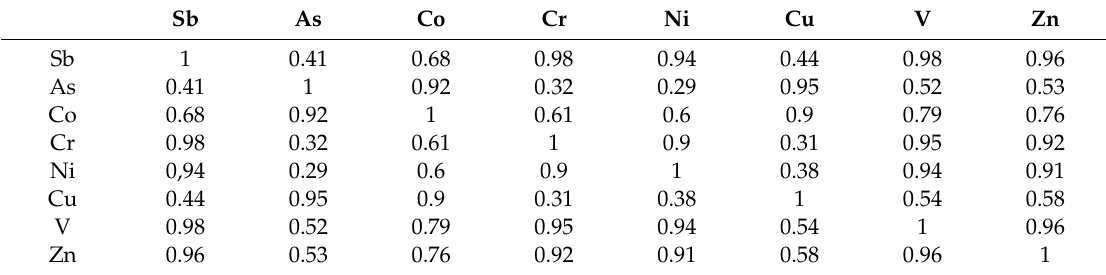
Table 2. Correlation matrix between analytes (1 = maximum positive correlation; 0 = no